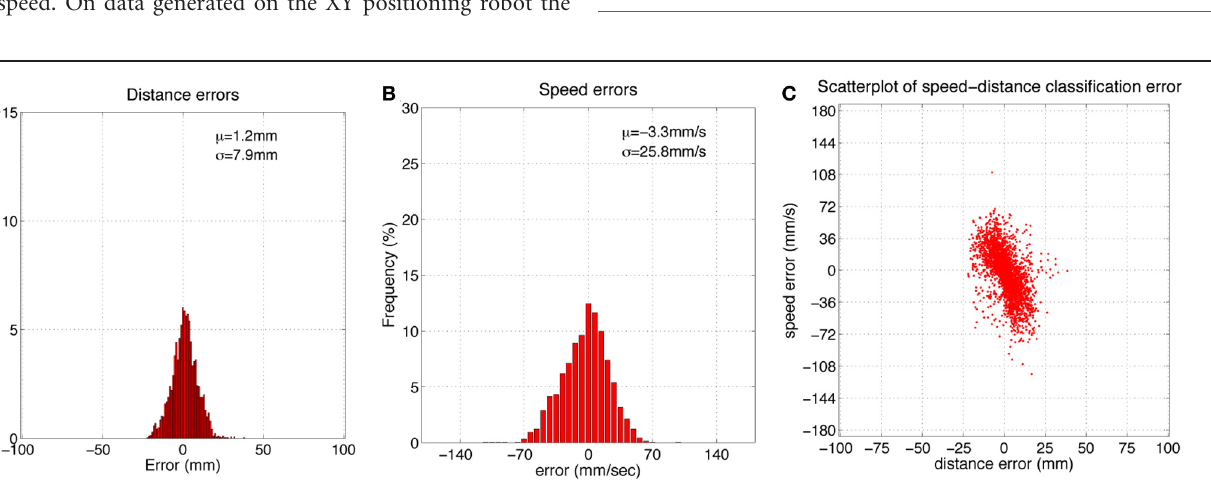
FIGURE 5 | (A,B) Histograms of radial distance and speed classification errors using the feature-based classifier. (C) Scatterplot of these errors for each point in the dataset. μ = mean, σ = standard deviation, sample size =